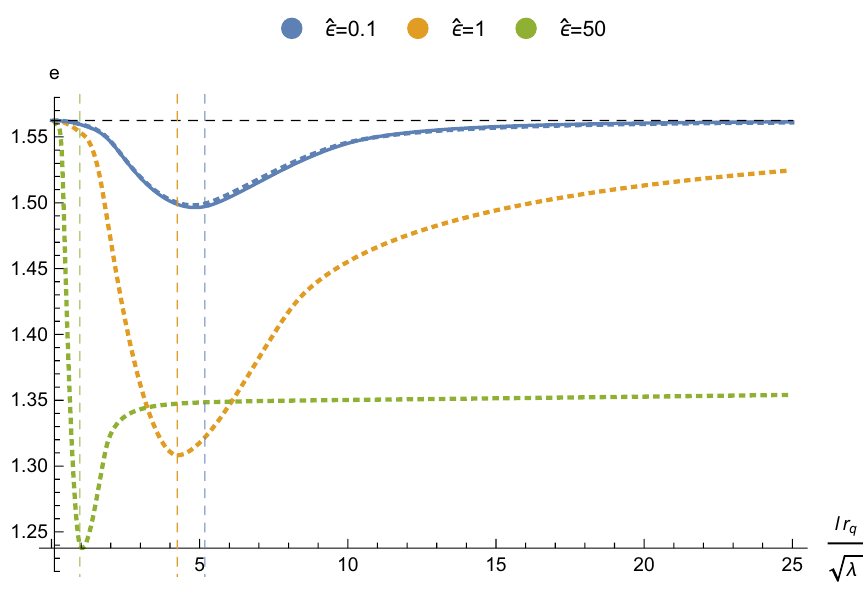
Figure 9 . Extensivity ( e ) as a function of the width l of the entangling strips shown for a (cid:12)xed ratio of strip separation to strip width ( s=l = 0 : 5). The extensivity only depends on the dimensionless p combination lr q = (cid:21) . The black, dashed horizontal line is the result in a conformal background (^ (cid:15) = 0 or massless quarks) and s=l = 0 : 5, and is thus the limit approached in the deep UV ( l ! 0) p and deep IR l ! 1 for any quark mass. Vertical dashed lines are l q r q = (cid:21) where l q is the width of the strip whose bulk minimal surface just touches the cavity for each ^ (cid:15) = (3 = 4)( N f =N ) (cid:21) , and thus represent the scale where quarks have the largest e(cid:11)ect on the dynamics. Dashed lines are numerical results and the solid line is our analytical small ^ (cid:15)